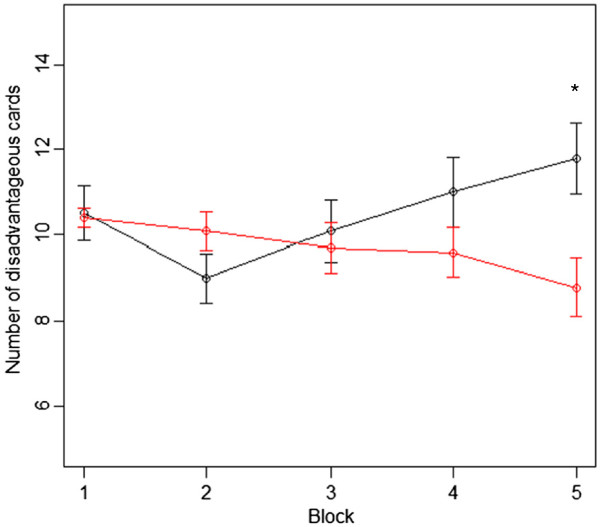
Order of card selection from the 1st to the 100th trial.The black and red lines show the mean number of disadvantageous cards drawn by OCD patients and controls, respectively, in each block of 20 cards. Horizontal bars indicate standard error of the means. Children with OCD chose more cards from the disadvantageous deck towards the end of the task. OCD, obsessive compulsive disorder; * Significantly higher compared to controls (Mann–Whitney test; P < 0.05).